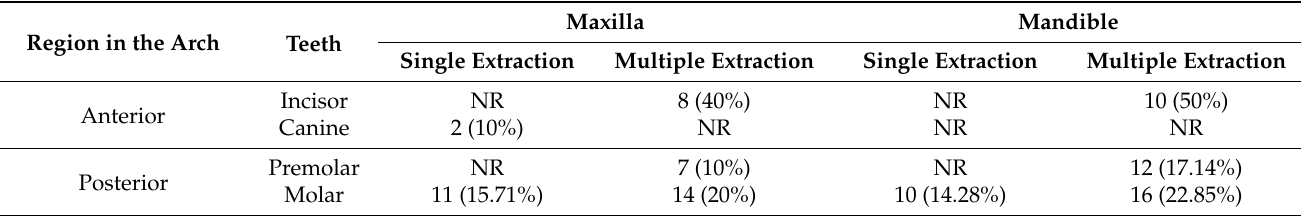
Table 1. Incidence of dry socket in participants ( n = 90).